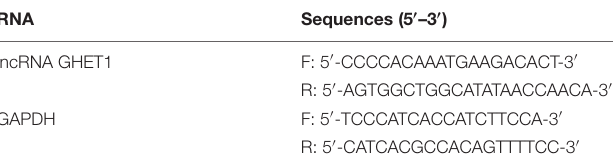
TABLE 1 | Primer sequences. RNA